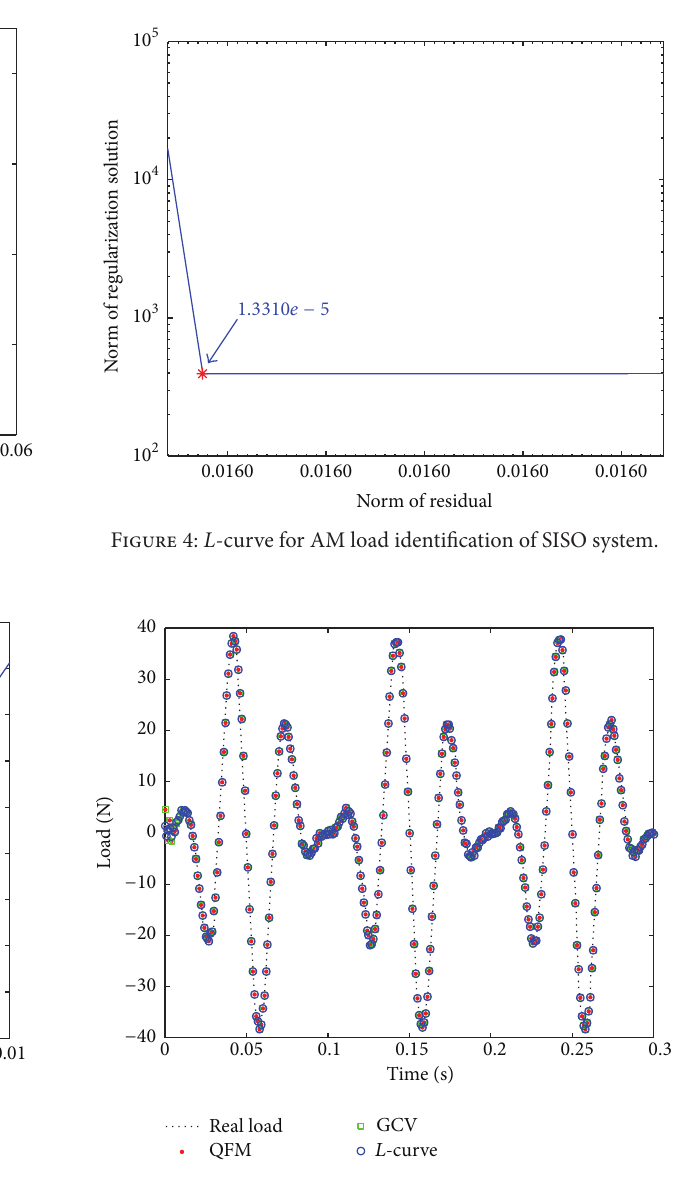
Figure 5: Identified AM load of SISO